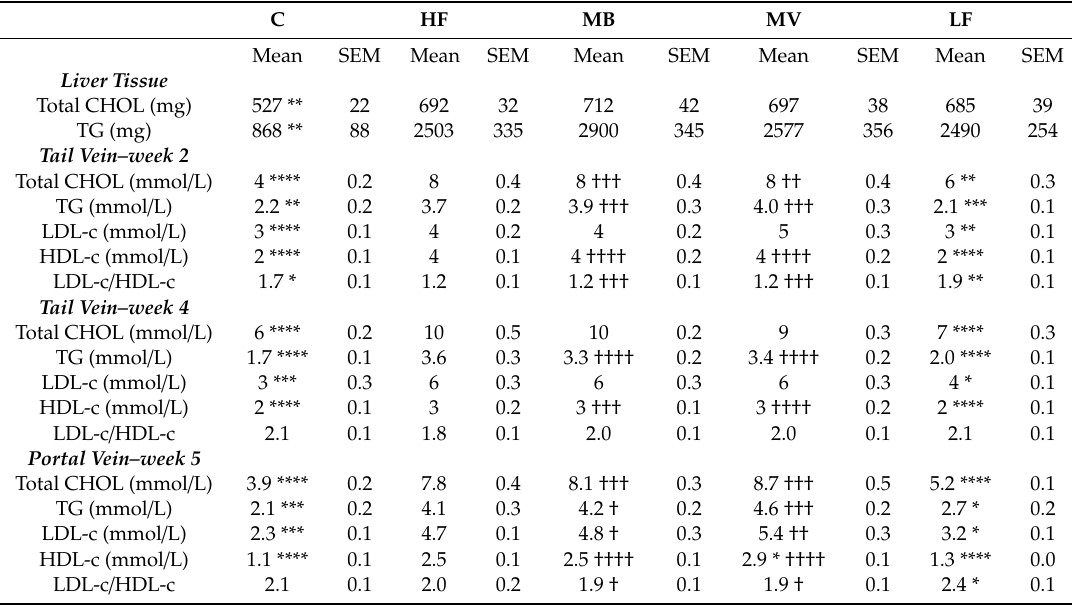
Table 1. Lipids in the liver and serum from the tail and portal vein in conventional rats fed a pure high-fat diet (C), or in Apolipoprotein E-knockout (ApoE- / -) rats fed a low-fat diet (LF) or high-fat diets (HF), pure or supplemented with 1% monobutyrin (MB) or monovalerin (MV) at week 2, week 4, and at the end (week 5) of the study ( n = 10 / group). Values are means ± SEM. C HF